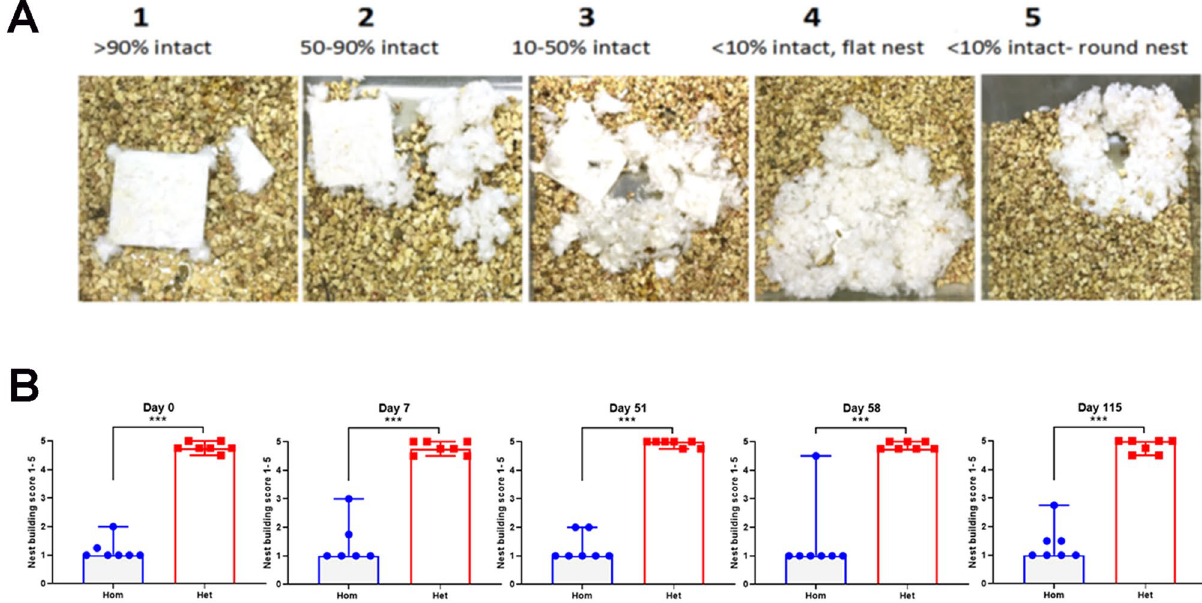
Figure 8. Nest building assay for behavioral competence. ( A ) Nesting behavior was assessed in the home cages using packed cotton material. The mice first shred the tightly packed material, then arrange it into a nest overnight. Semiquantiative score, shown above the images, is assigned based on the quality of the nest. ( B ) Scatter plot graphs show individual animal nesting score. n = 7 Hom, 7 Het. Group columns represent median scores and the error bars indicate range in Hom and Het mice at various timepoints (*** p =